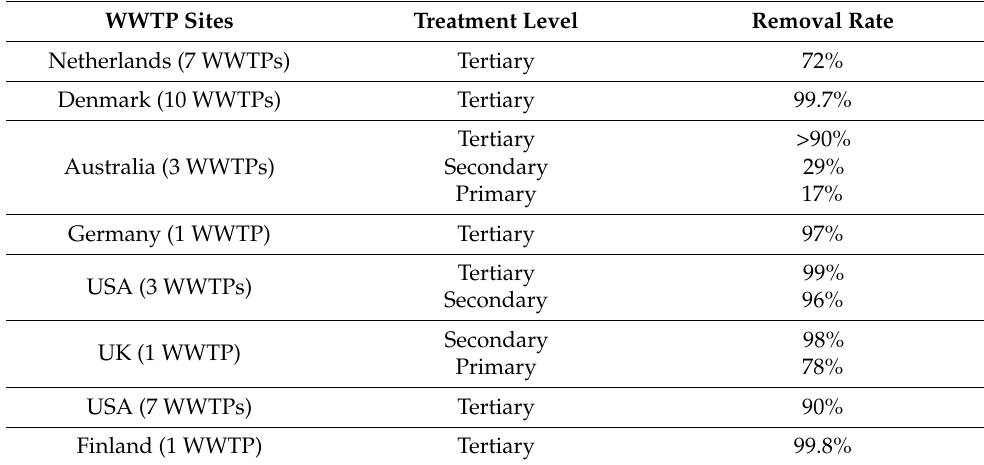
Table 2. WWTP MPs retention depending on treatment level adapted from [19], with